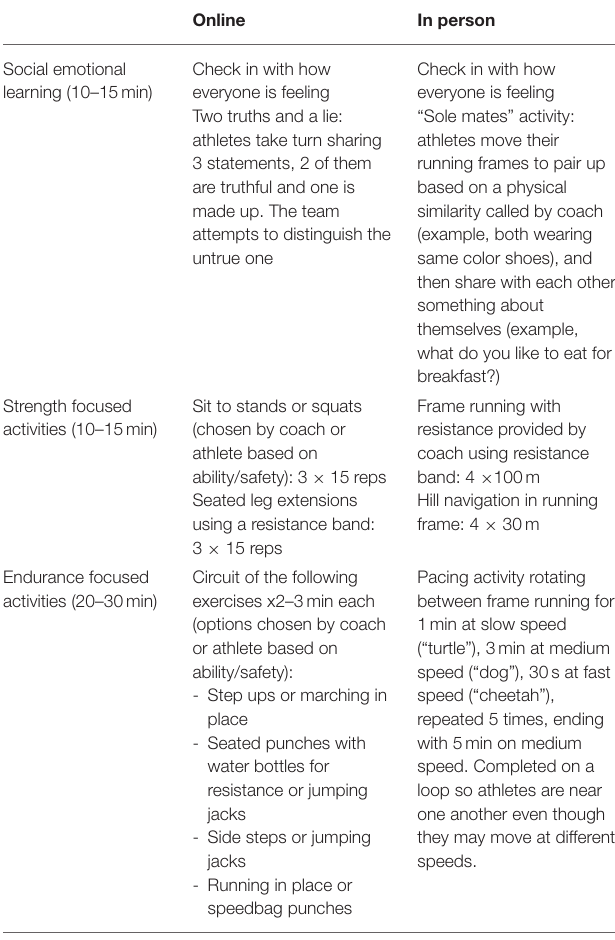
TABLE 1 | Example training session schedule.